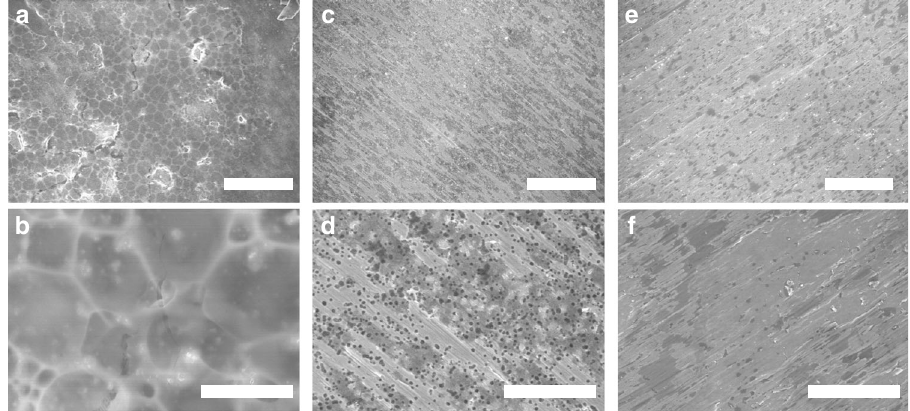
Fig. 2 SEM analysis of the lithium anode. Top view SEM images of lithium stripping after three cycles at 0.5 mA cm − 2 for 0.4 h with untreated electrolyte ( a , b ), with PEGDME ( c , d ), and OP-10 additives ( e , f ) (Scale bars: a , c , e 100 μ m; b , d , f 20 μ